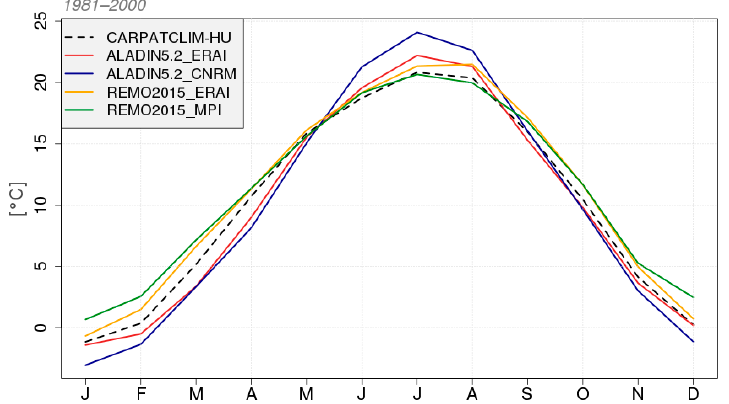
Figure 4. Monthly mean temperature in Hungary in 1981–2000 based on the CarpatClim-HU observation dataset and the four RCM simulations (ALADIN5.2_ERAI, ALADIN5.2_CNRM, REMO2015_ERAI and REMO2015_MPI). Table 4. Seasonal and annual temperature bias ( ◦ C) of the four model simulations over Hungary in comparison with the CARPATCLIM-HU observation dataset. Period: 1981–2000. Model Simulation MAM JJA SON